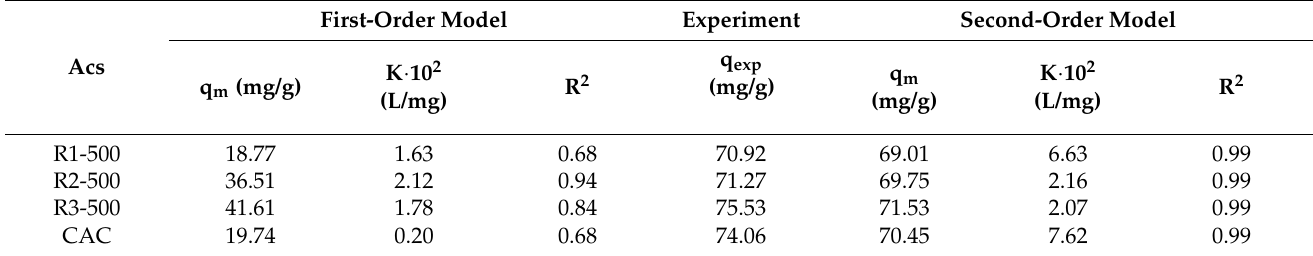
Table 6. Parameters obtained from kinetics curves of atenolol (C 0 = 50 mg/L; adsorbent concentration = 50 mg/L).